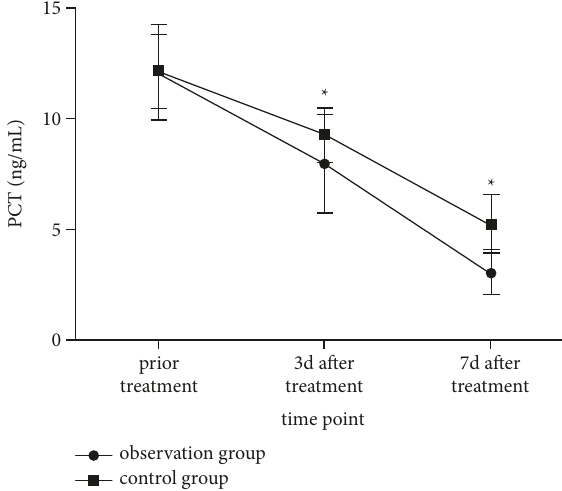
Figure 14: Comparison of PCT between the two groups before and after